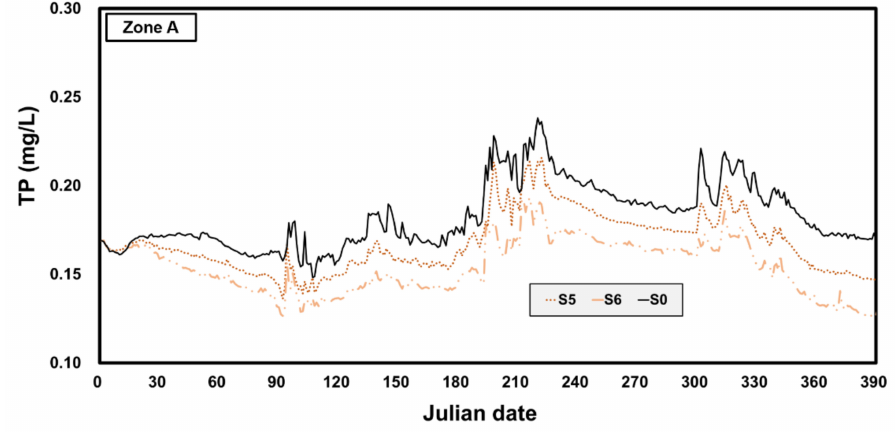
Figure 9. Simulated results of T-P concentration (Zone A, S0, S5–S6).